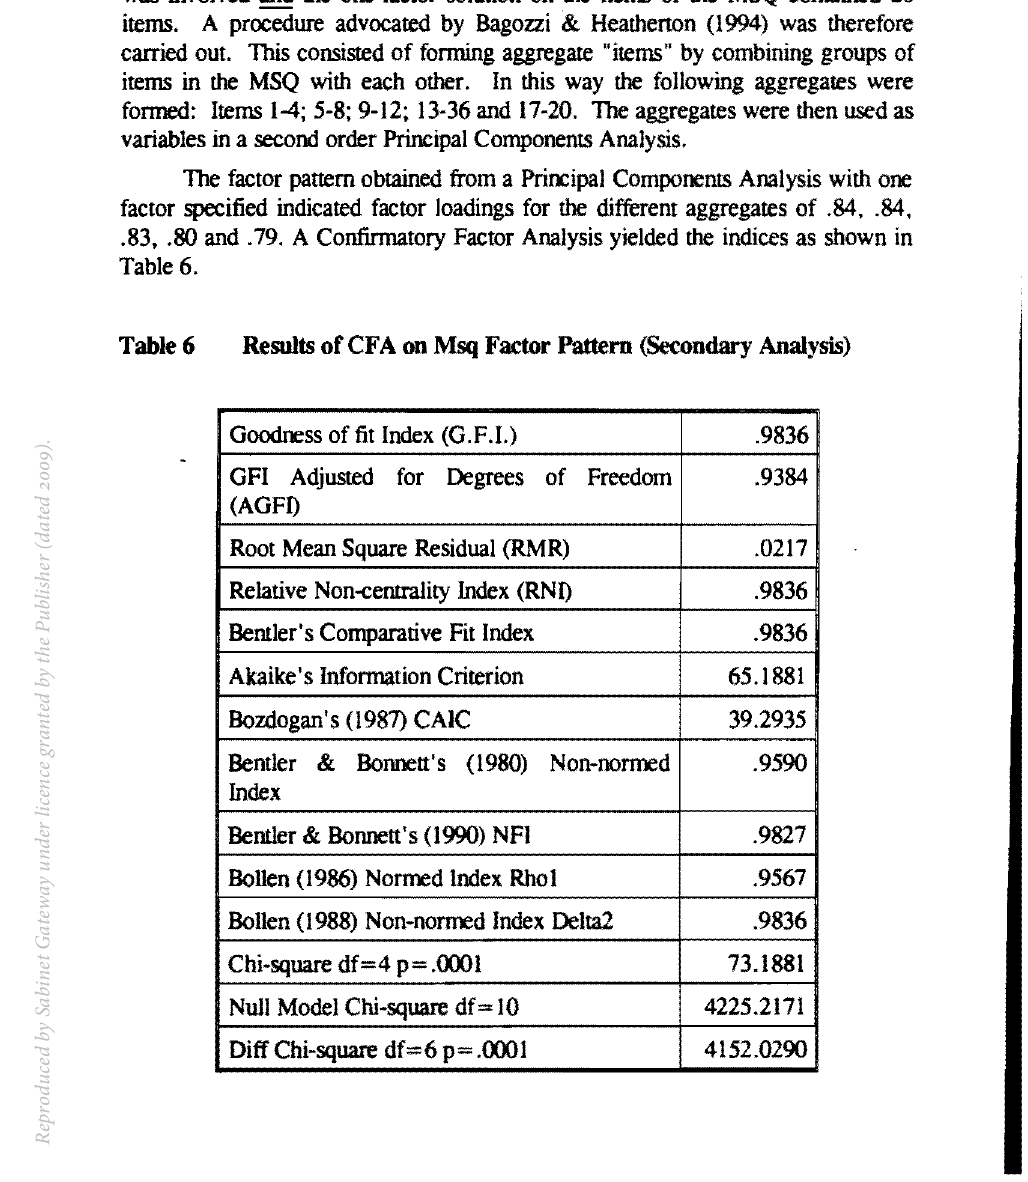
Results of CF A on Msq Factor Pattern (Secondary Analysis) Goodness of fit Index